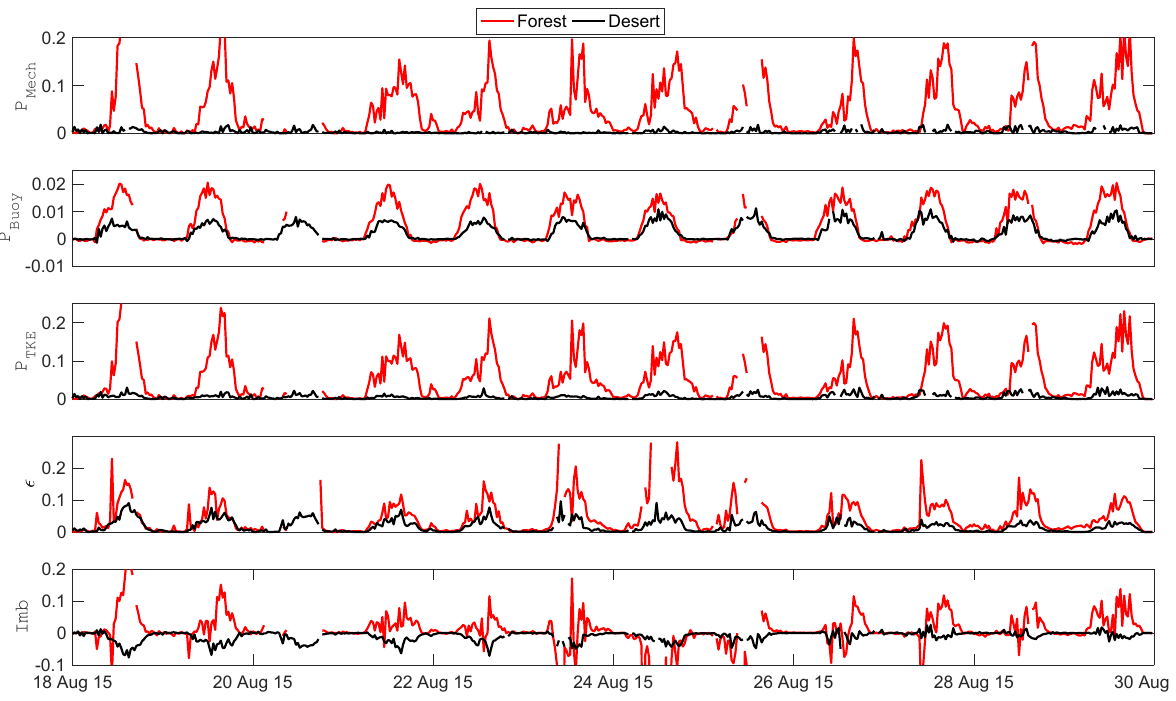
Figure 4. Time series of mechanical production of TKE (m 2 s − 3 ), buoyant production of TKE (m 2 s − 3 ), full TKE production (m 2 s − 3 ), dissipation of TKE (m 2 s − 3 ) and imbalance of TKE (m 2 s − 3 ). The black line indicates desert, and the red line indicates